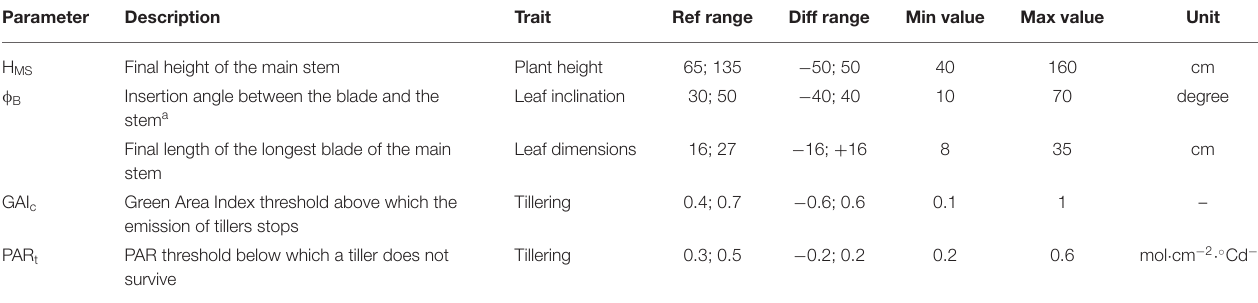
TABLE 1 | List of parameters for the sensitivity analysis, definitions, traits impacted by the parameter, ranges of variation explored for the mean parameter value in the stand (Ref range) and for the difference of trait value between the two varieties of the mixture (Diff range), corresponding minimum and maximum values at the plant scale and